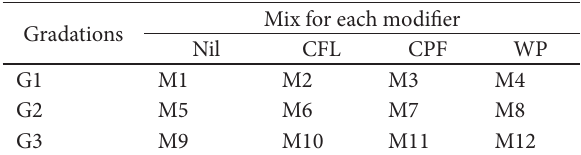
Table 2. Details of experimental mix combinations